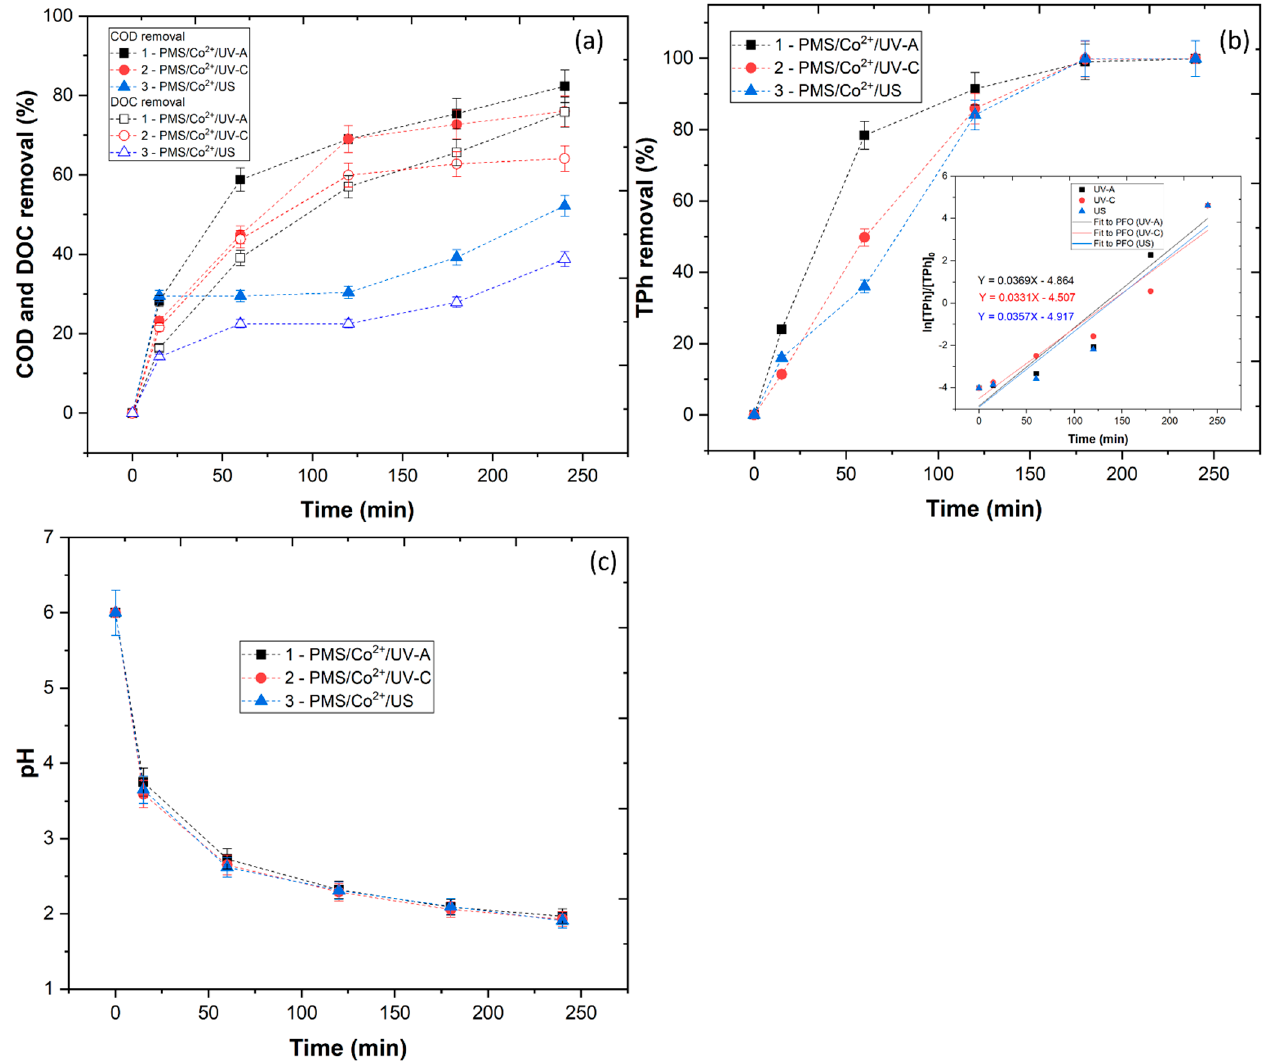
Figure 7. Evaluation of the PMS/Co 2+ /UV system with three radiation reactors (UV-A, UV-C and US) in ( a ) COD and DOC removal, ( b ) TPh removal and ( c ) pH. Operational conditions: pH i = 6.0, [PMS] = 5.88 mM, [Co 2+ ] = 5 mM, T = 343 K, time = 240 min.